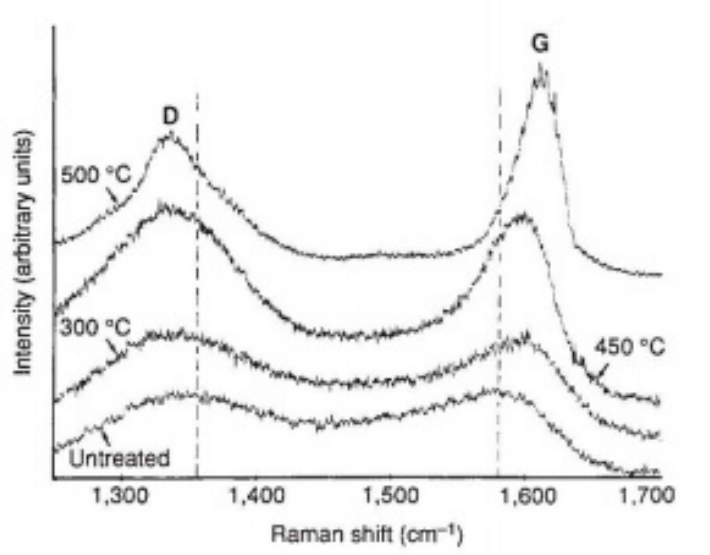
Figure 42. Raman spectra of the LoxM-garde Tyranno fibers before and after hydrothermal treatments at various temperatures. Ar laser radiation at a wavelength of 488 nm was used. Vertical dashed lines show the predicted positions of the nanocrystalline graphite line (G) at ~1580 cm − 1 and its disorder-induced line (D) at ~1355 cm − 1 . The shift of the observed lines indicates the presence of bond-angle disorder. Reprinted with permission from Reference [126]. Copyright 1994 Springer Nature.